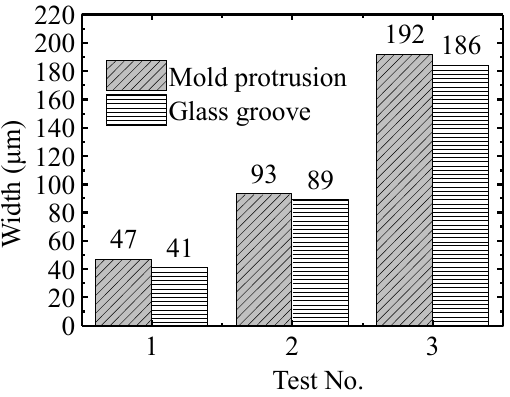
Figure 9. The width comparison between mold protrusions and glass grooves.